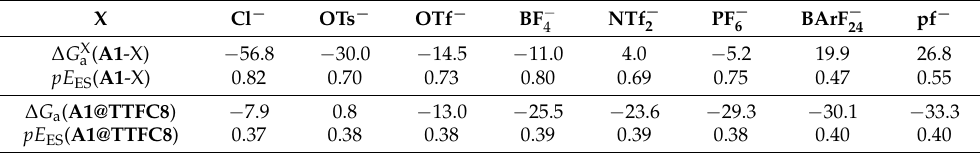
Table 4. FMO-EDA results obtained at the ω B97XD/cc-pVDZ[62] level, in comparison to Gibbs association free energies obtained at the SMD/M06-2X/def2-TZVP level, in terms of the inter- action of A1 with an anion X ( ∆ G X a ), and the inter-component interaction between TTFC8